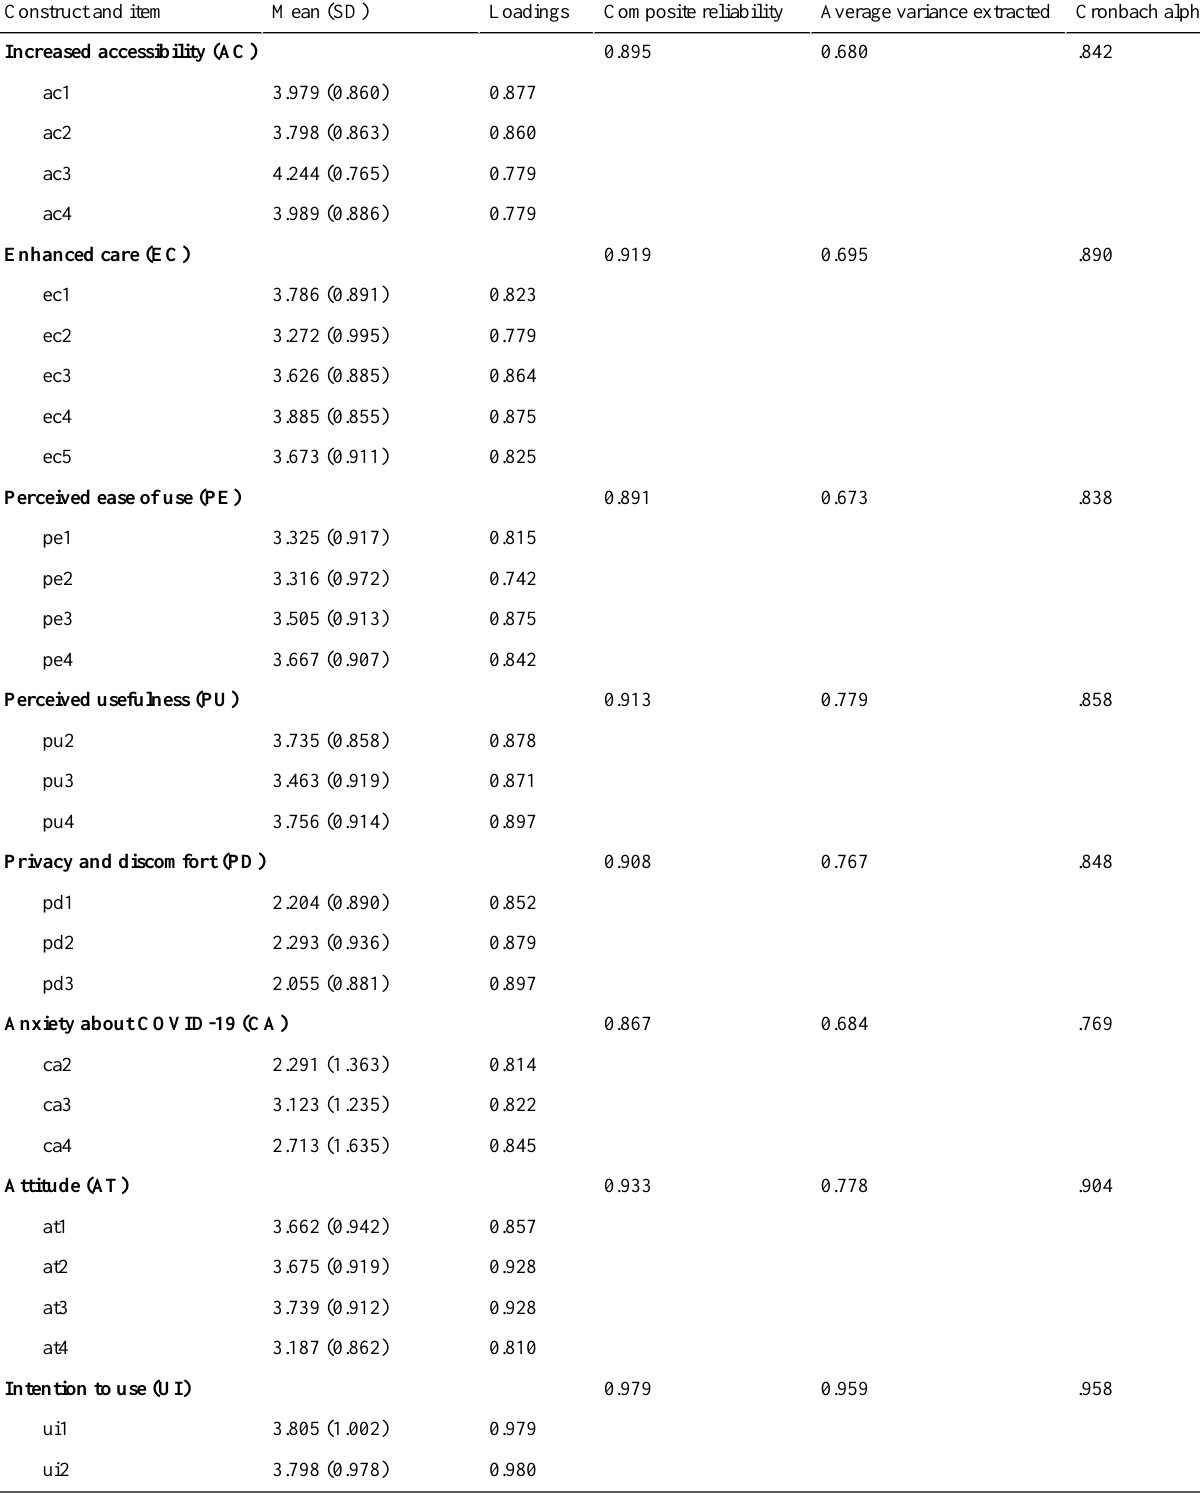
Table 3. Factor loadings and